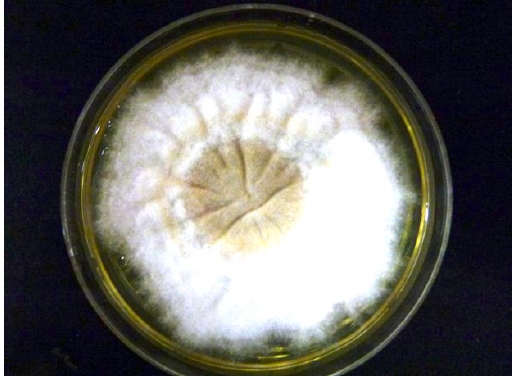
Figure 2. Adhesive tape sample containing scales and hair placed on Sabouraud dextrose agar plate. Growth of colonies of dermatophyte was seen from the edges of the tape at Week 3.